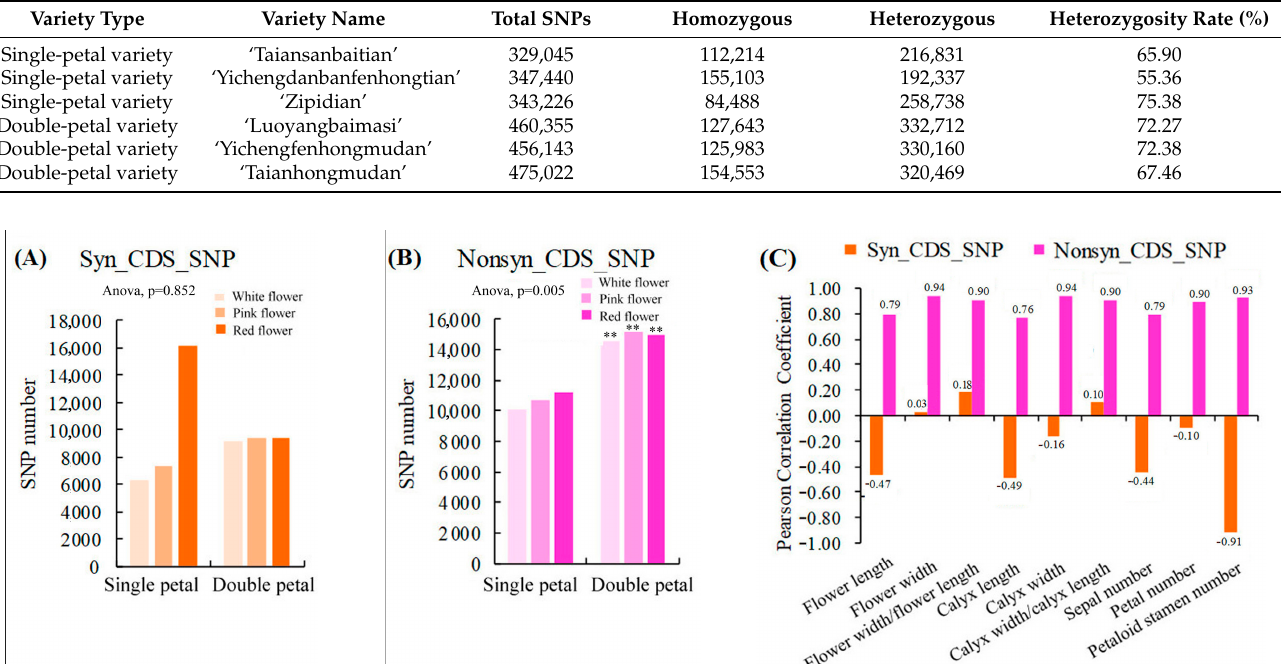
Table 3. SNPs statistics of six ornamental pomegranate varieties.